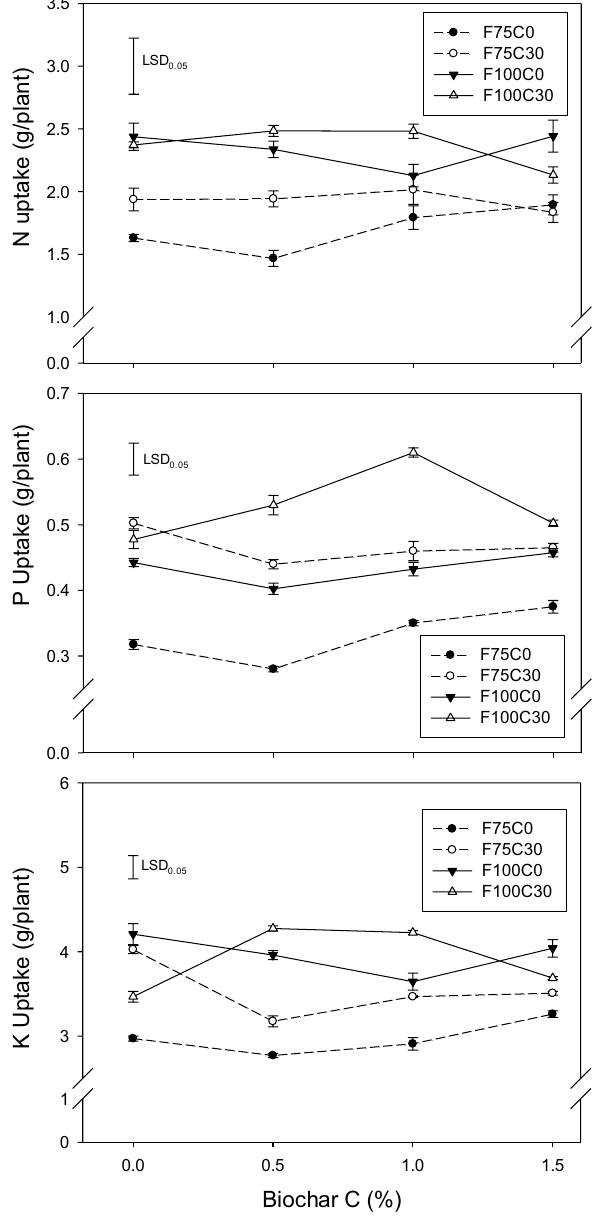
Fig. 5 The interactive effect of fertiliser rates (75 and100%) and bio- char rates (0, 0.5, 1.0 and 1.5% C addition) in media without and with compost treatment (0 and 30% v/v compost) on N, P and K uptake (mean ± standard error), ( n = 4). Note: F75C0 75% fertiliser recom- mended rate in soil without compost; F75C30 75% fertiliser recom- mended rate in soil with 30% v/v compost; F100C0 100% fertiliser recommended rate in soil without compost; F100C30 100% fertiliser recommended rate in soil with 30% v/v